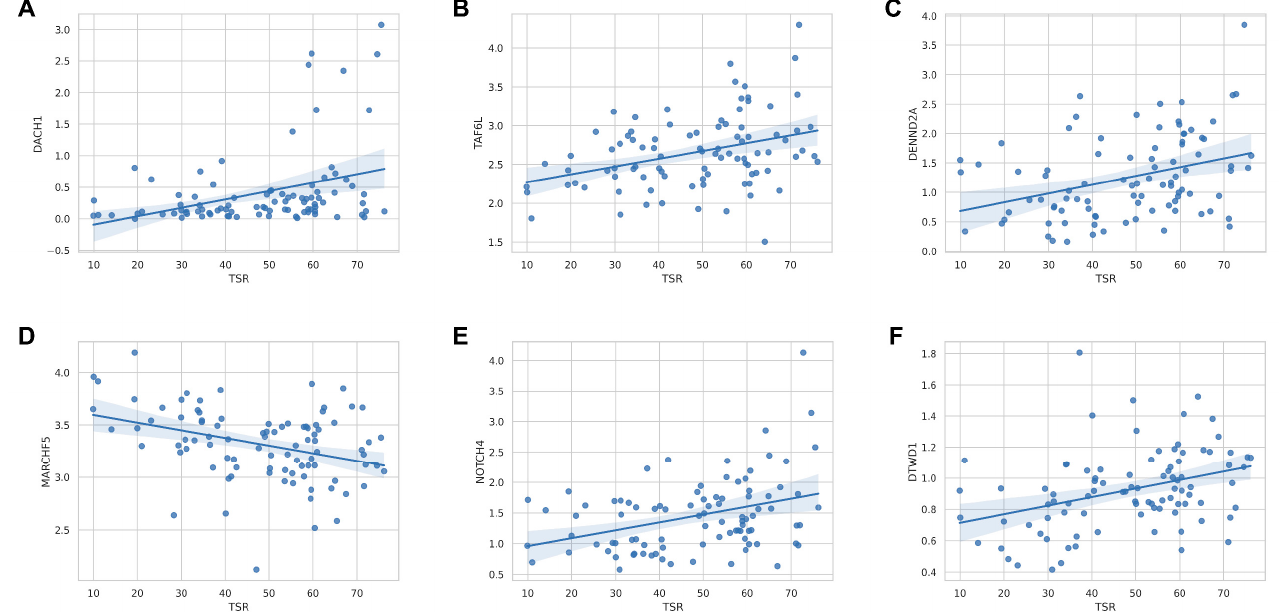
Figure 5. Correlates between ML-based TSR and gene expression levels. Biological correlation between TSR and ( A ) the DACH1 expression (N = 92 samples), ( B ) the TAF6L expression (N = 91 samples), ( C ) the DENND2A expression (N = 92 samples), ( D ) the MARCHF5 expression (N = 92 samples), ( E ) the NOTCH4 expression (N = 92 samples), and ( F ) the DTWD1 expression (N = 92 samples) available for the TCGA dataset.